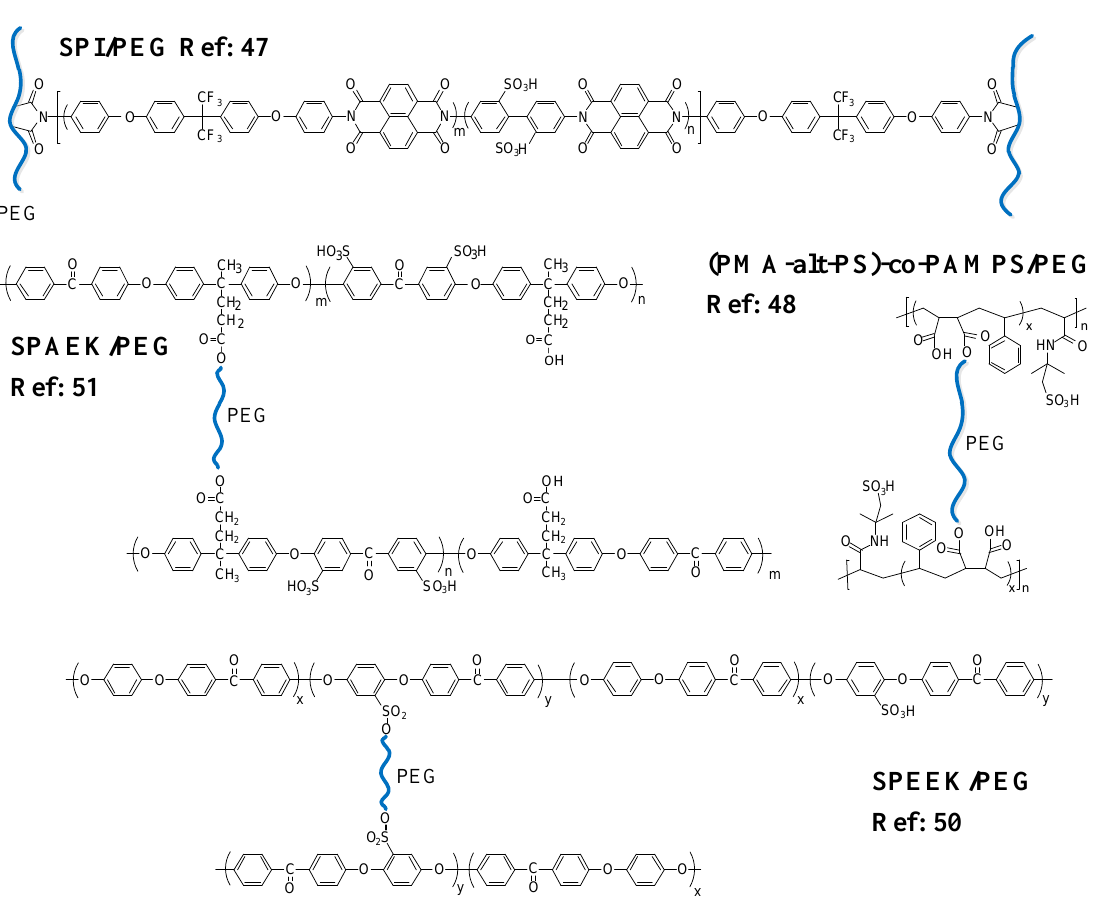
Figure 8. Proposed structure of sulfonated polymer/ Poly (ethylene glycol) (PEG) crosslinked